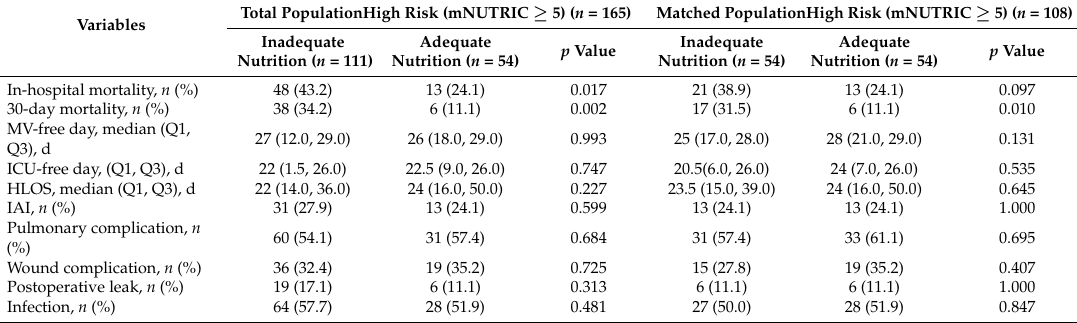
Figure 2. Kaplan–Meier survival curves for adequate and inadequate calorie supplementation in patients with low mNUTRIC score ( left ) and high mNUTRIC score ( right ); propensity score matching was performed for high mNUTRIC score group. The curves on the left demonstrate that there is no survival benefit after adequate calorie supplementation in patients with low mNUTRIC (log-rank test, p = 0.152), but the curves on the right demonstrate that there is a significant survival benefit in the adequate nutrition group (log-rank test, p = 0.022). Table 4. Clinical outcomes of patients with high mNUTRIC